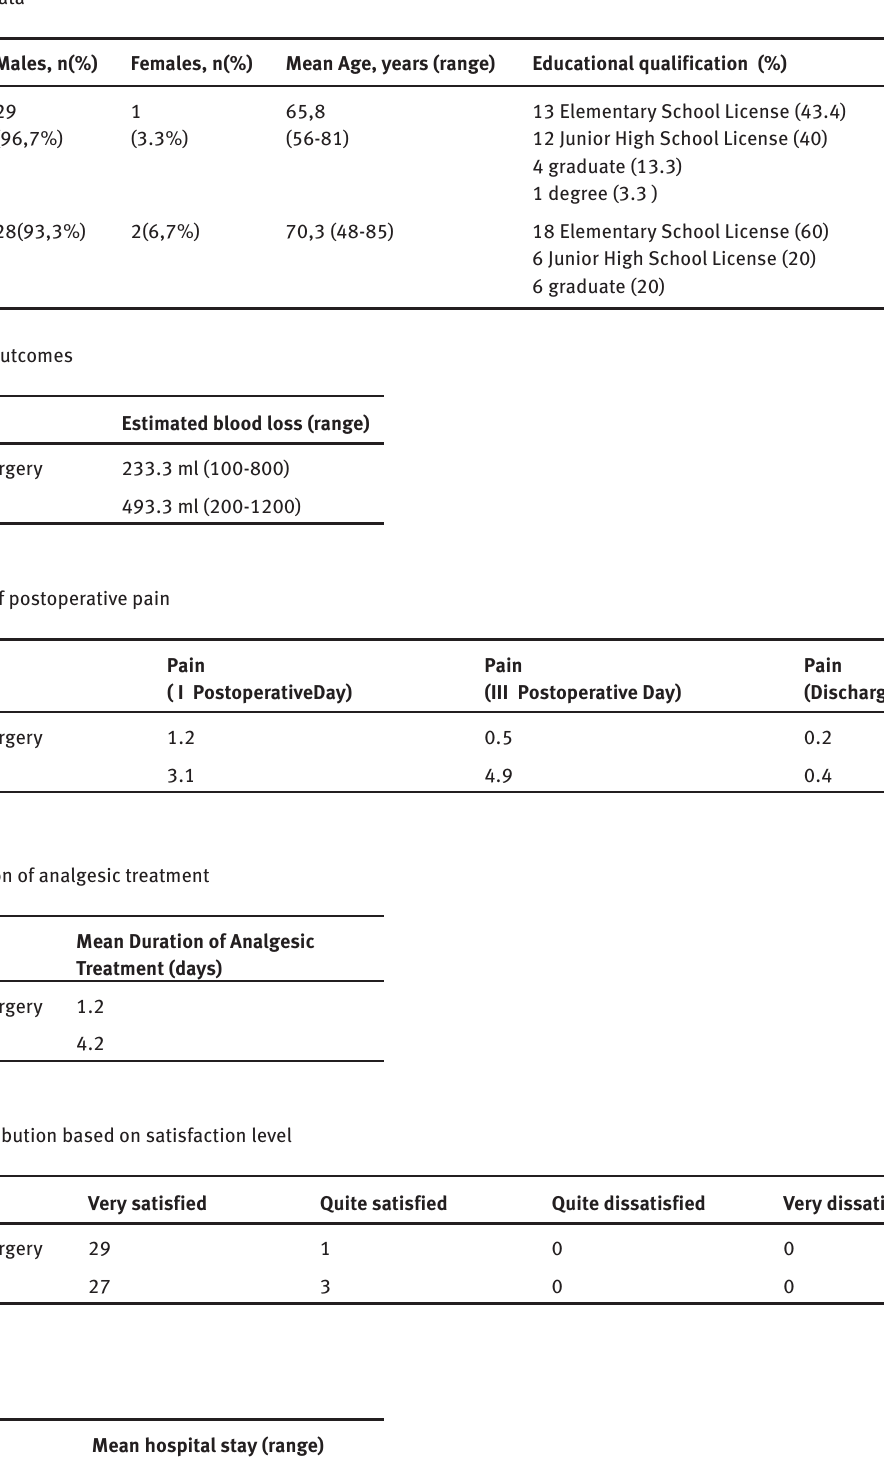
Table 1: Demographic data